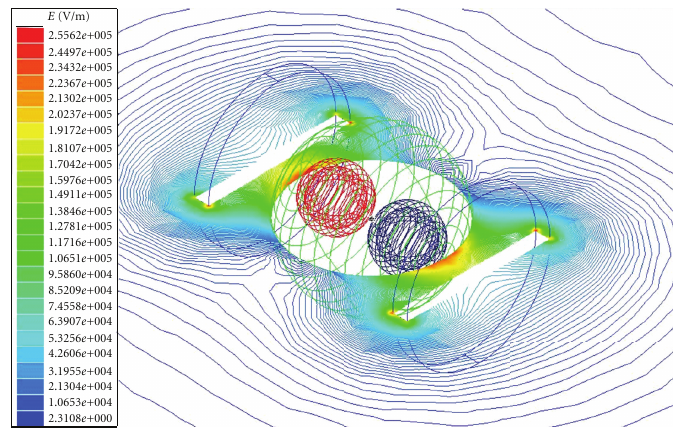
Figure 3: Electric field distribution for breast lobe tissue with tumor cells (plane